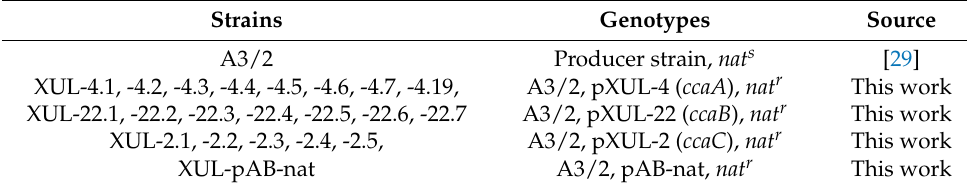
Table 1. Acremonium chrysogenum strains used in this work. Strains